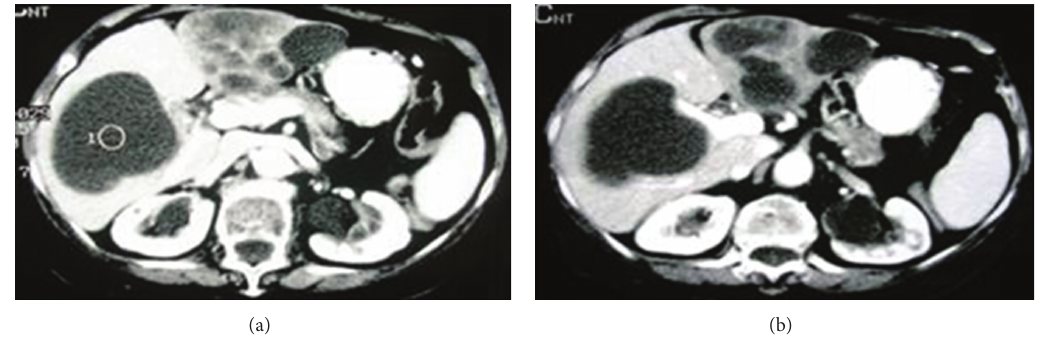
F 2: CT scan demonstrating cystic lesions or hypodense hepatic masses covering almost the entire part of the hepatic